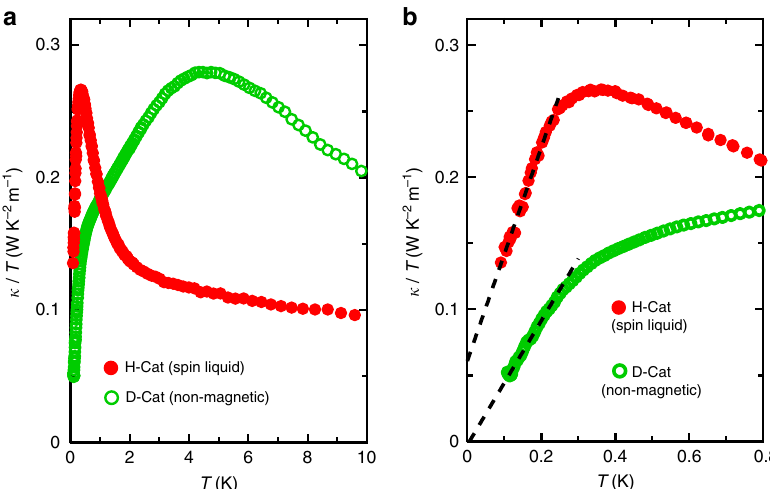
Fig. 3 Thermal conductivity of H-Cat and D-Cat. a Temperature dependence of κ / T of H-Cat ( fi lled red symbols) and D-Cat (open green symbols) below 10 K in the zero- fi eld. b Low-temperature thermal conductivity for H-Cat and D-Cat below 0.8 K in the zero- fi eld. The extrapolated data (dashed lines) assume that κ ph ∝ T 2 (for details, see Supplementary Note 3). A clear residual κ / T in the zero-temperature limit is resolved for H-Cat. The peak structure of κ H / T around 0.3 K is considered to arise from both κ H and κ H (See Supplementary Note 6) sp ph